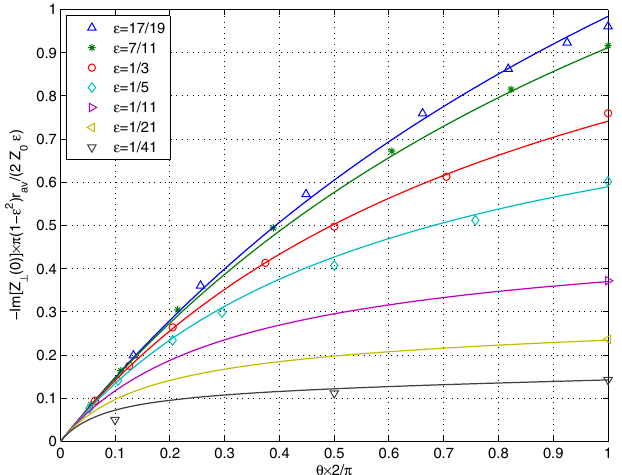
FIG. 4. (Color) The dimensionless scaled impedance as calcu- lated from ABCI (symbols) and the curves corresponding to approximation given in Eqs. (3.5) and (3.6)